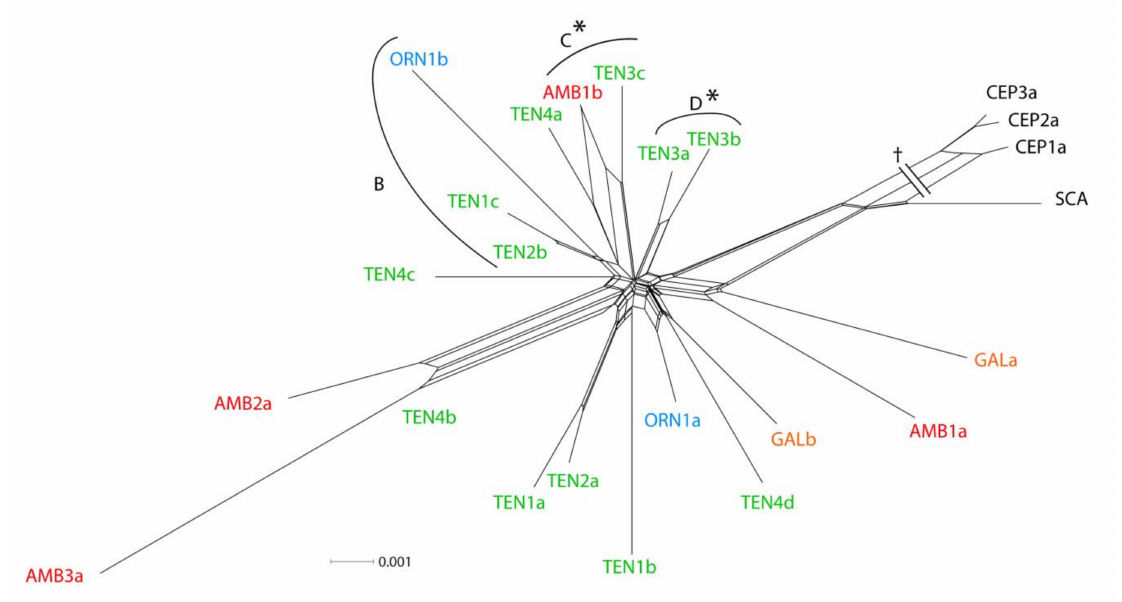
Figure 4. Neighbor-Net for the AGT1 region of Centaurea tentudaica. Letters correspond with the clades, shown in Figure S2. * indicates the statistically supported clades in the Bayesian analysis with a posterior probability above 0.90. † = 0.029.